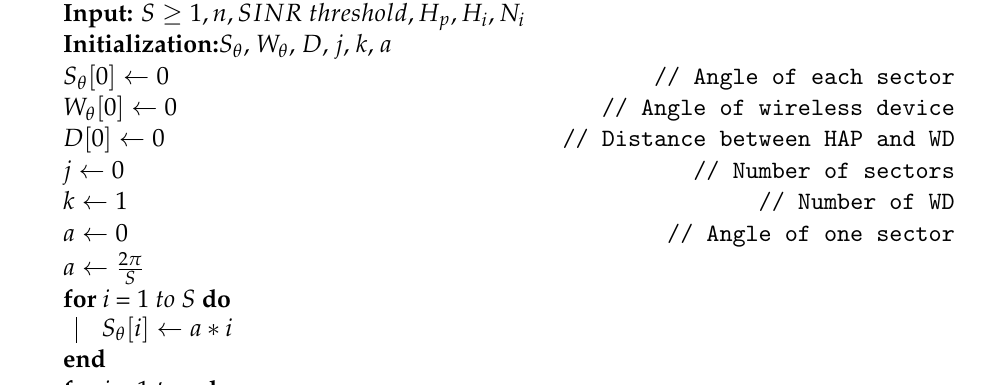
Algorithm 1: Wireless device distribution and